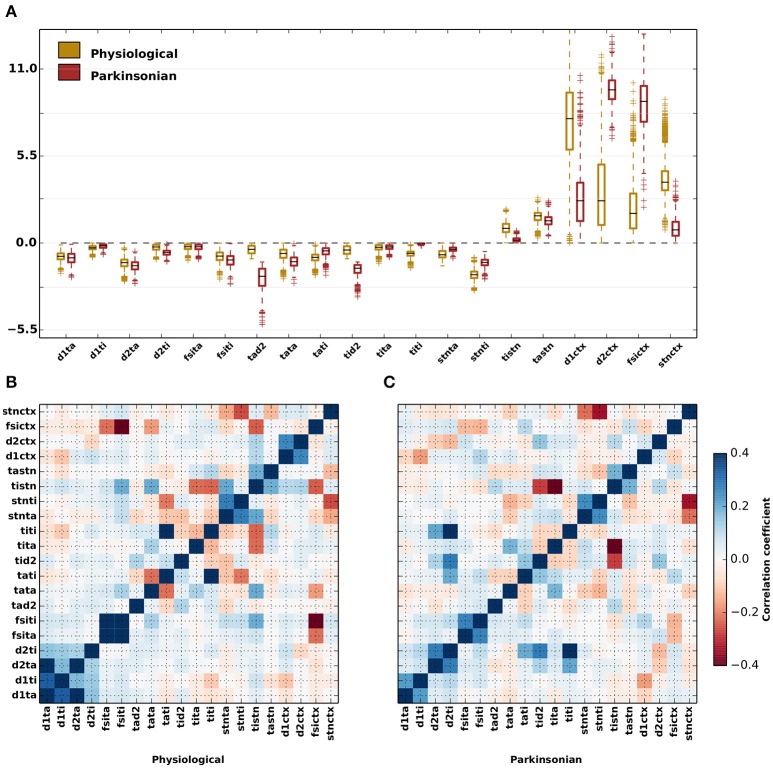
Variability of parameters for parkinsonian and physiological network configurations. (A) Distributions of values generated by the genetic algorithm for each of the free parameters displayed as box plots for physiological (yellow) and parkinsonian (red) networks. The black lines within the box plots represent the median values, whereas the box caps represent the 25% (Q1) and 75% (Q3) quartiles of the distributions. The whiskers represents the margin: (Q1–1.5×IQR, Q3+1.5×IQR), where IQR = Q1 − Q3. Outliers to the margins are represented by “+” markers. The values of the medians and quartiles are listed in Table 5. (B) Correlation coeffiecients between the free parameters for physiological networks (C) As in (B) but for parkinsonian networks.